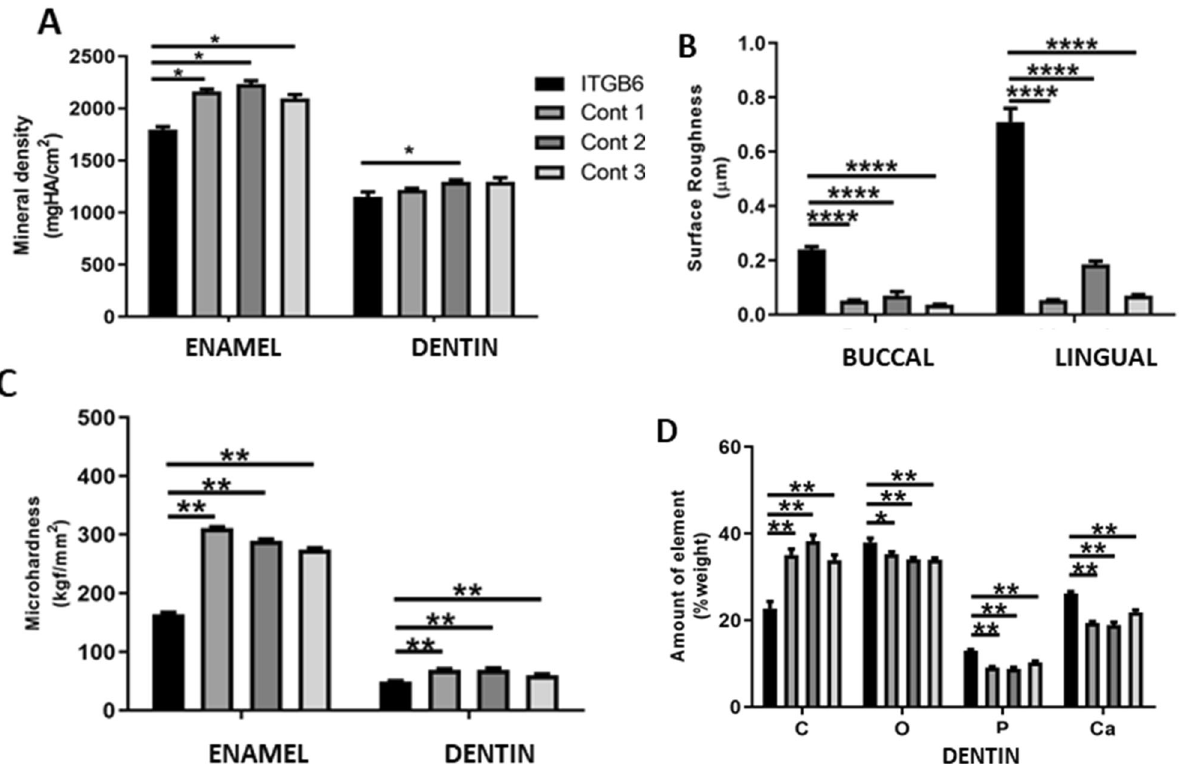
Fig. 3 Tooth characteristics. A The patient ’ s tooth showed a signi fi cant reduction in mineral density compared with controls. B Surface roughness values of the patient ’ s tooth was signi fi cantly higher than those of controls. C Microhardness values of the patient ’ s enamel and